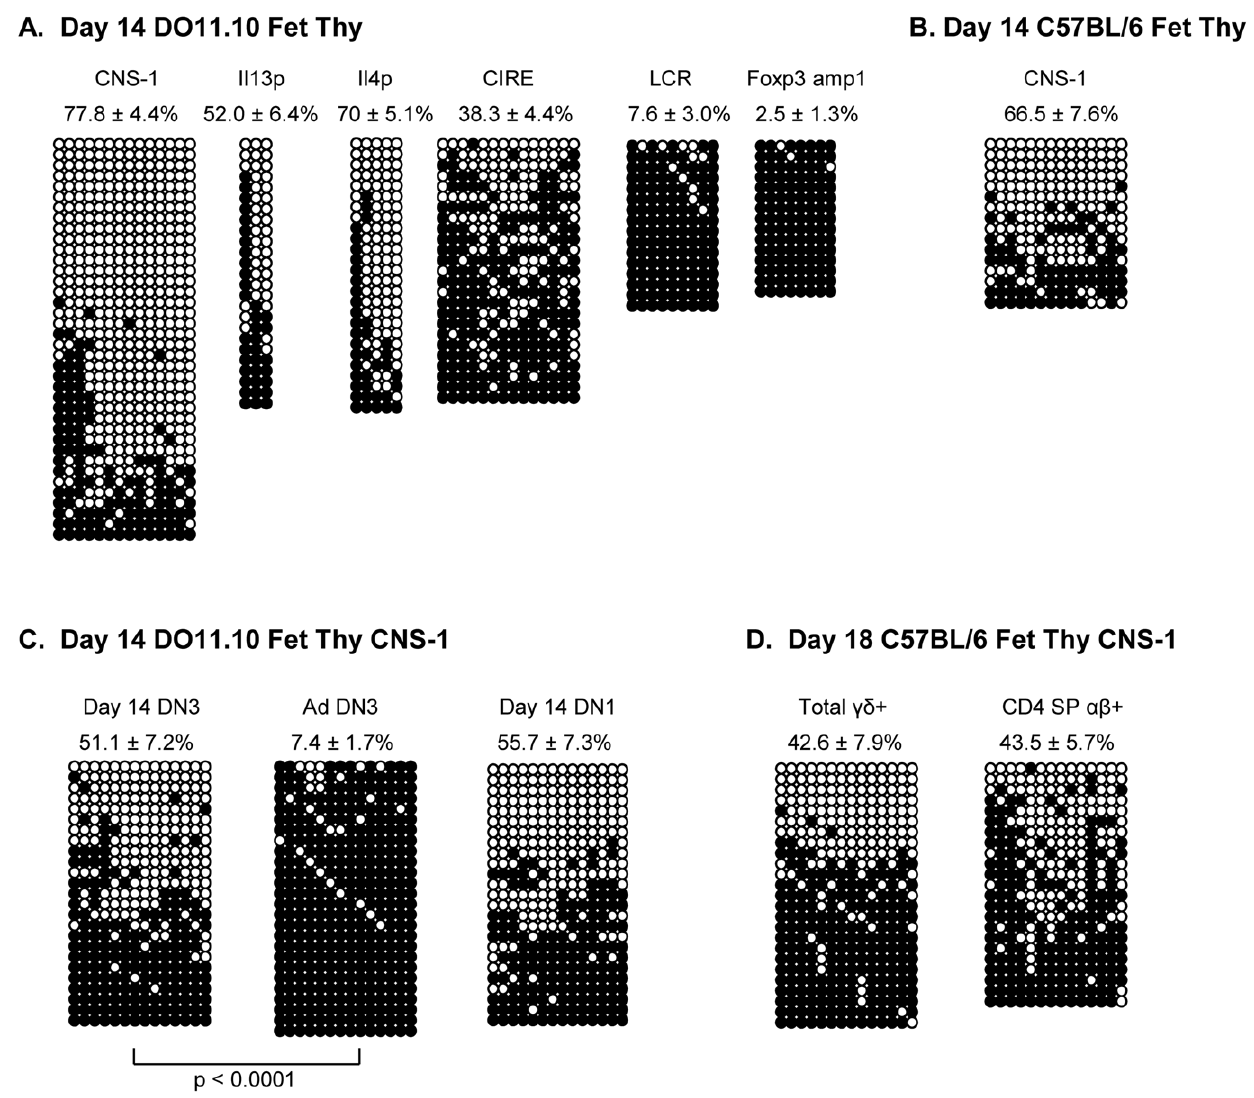
Figure 3. Extensive hypomethylation at the Th2 locus in day 14 fetal thymocytes. (A) Total day 14 fetal thymocytes from DO11.10 animals were assessed by bisulfite sequencing for the methylation status of CNS-1, IL-13p, IL-4p, CIRE, LCR, and Foxp3 amp1 as described for Figure 1. The average percentage unmethylated (among all of the individual clones in each group) 6 SEM is indicated for each site. (B) Bisulfite sequencing analysis of CNS-1 in total day 14 fetal thymocytes from C57BL/6 animals. (C) Bisulfite sequencing analyses of CNS-1 in DN3 (CD4 2 8 2 25 + 44 2 ) or DN1 (CD4 2 8 2 25 2 44 + ) cells from day 14 fetal or adult thymus, as indicated. (D) Bisulfite sequencing analyses of sort-purified cd + or CD4 SP ab + cells from 18 day fetal thymuses. All data shown are from two independent biological replicates. Mann Whitney analysis showed a significant difference (p , 0.001) in methylation at CNS-1 in fetal and adult DN3 cells.